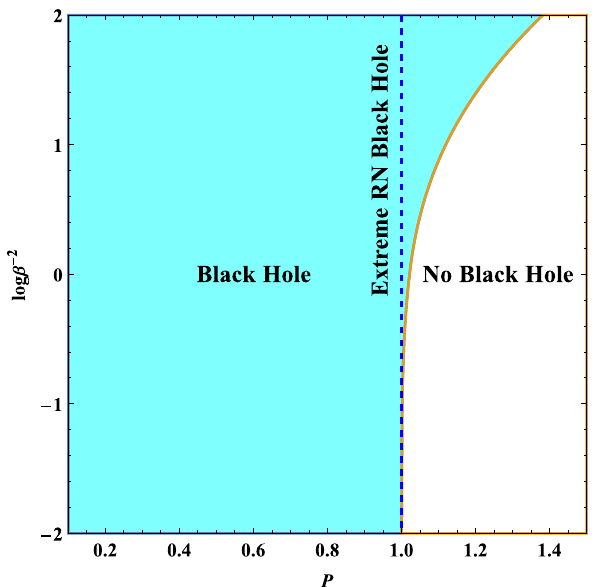
Fig. 1 Regionplotinthe P − log β − 2 parameterspaceformagnetically chargedBIblackholeswith m = 1.Blackholesexistinthecyanregion, and the blue dashed line stands for the extreme RN black hole. With the decrease of β , the upper limit of the magnetic charge P increases